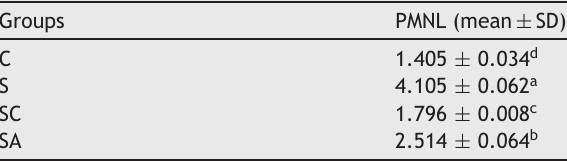
The statistical results of the numerical densities of Polymorphonuclear Leukocyte (PMNL) infiltration in the treatment and control groups.